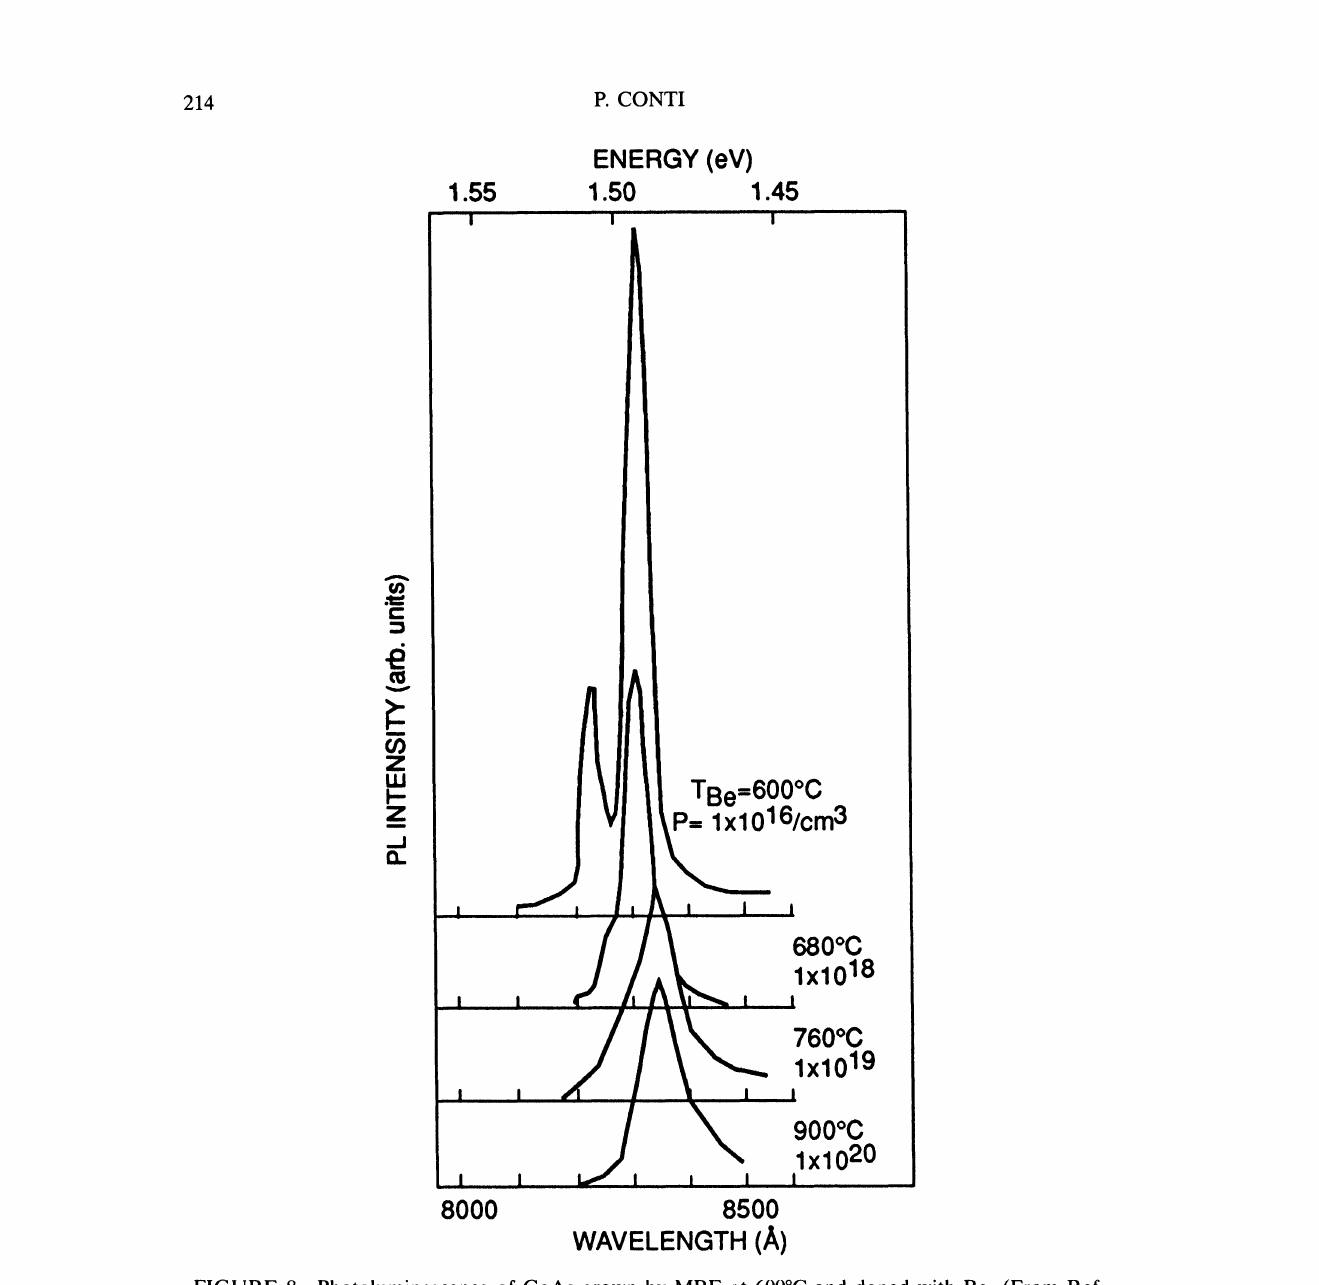
FIGURE 8 Photoluminescence of GaAs grown by MBE at 600C and doped with Be. (From Ref.